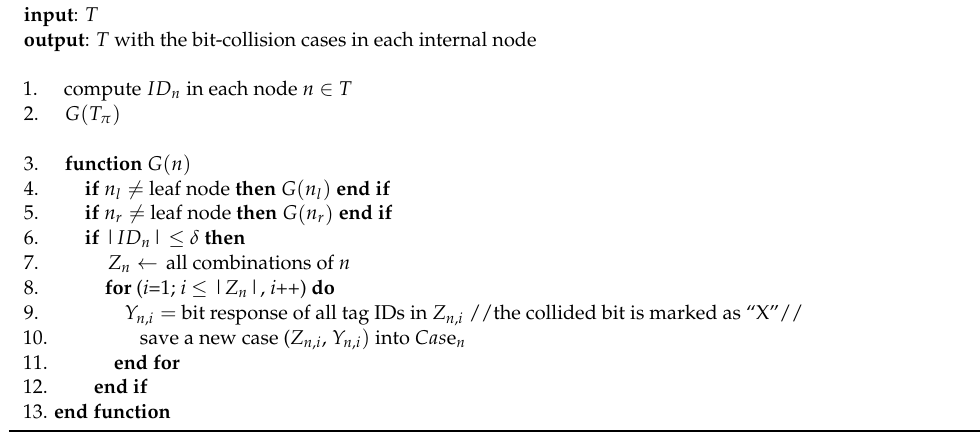
Algorithm 2. Pseudo-code for bit-collision